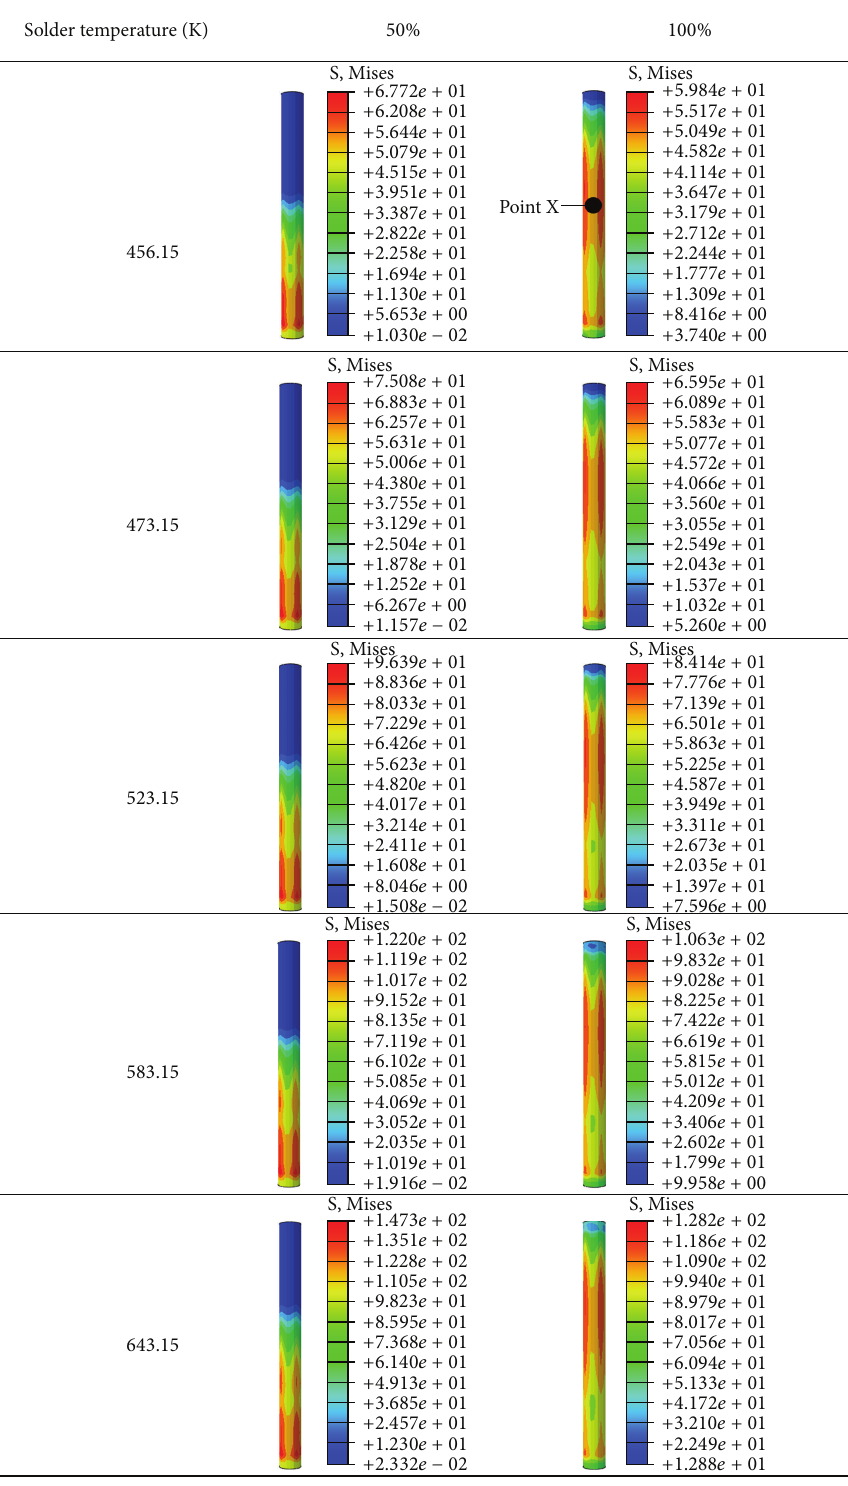
Figure 15: Stress distribution on